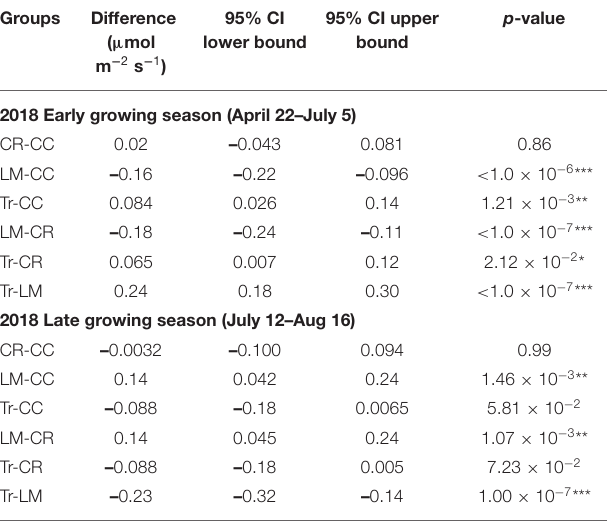
TABLE 4 | Mean transformed CO 2 flux group comparisons from four treatments in early ( n = 181) and late ( n = 161) growing seasons in 2018.